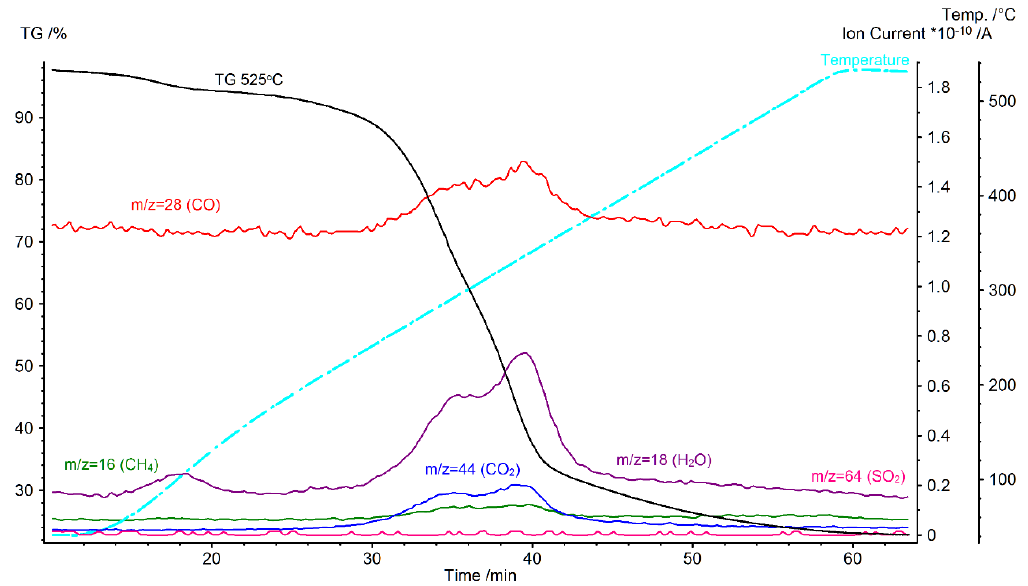
Figure 17. TG curve and ion current curves for the maize straw torrefaction process carried out up to 525 °C.